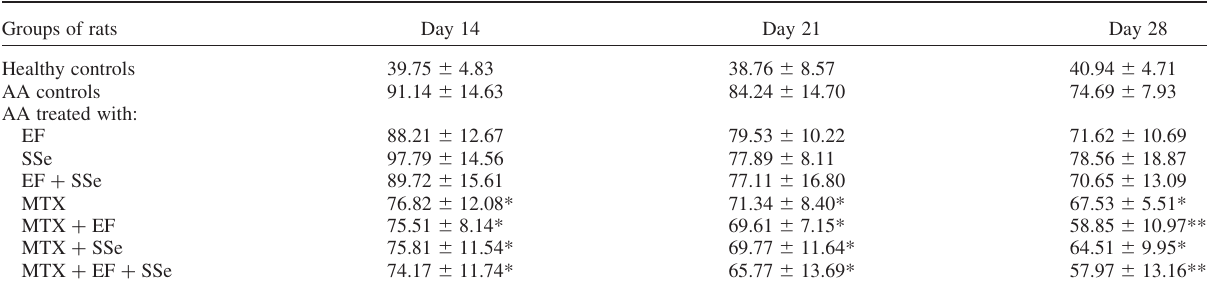
TABLE IV The effect of preventive treatment with methotrexate (MTX), E. faecium (EF), selenium (SSe) and their combinations on serum nitrite/nitrate concentrations (nmol/ml) in rats with AA Groups of rats